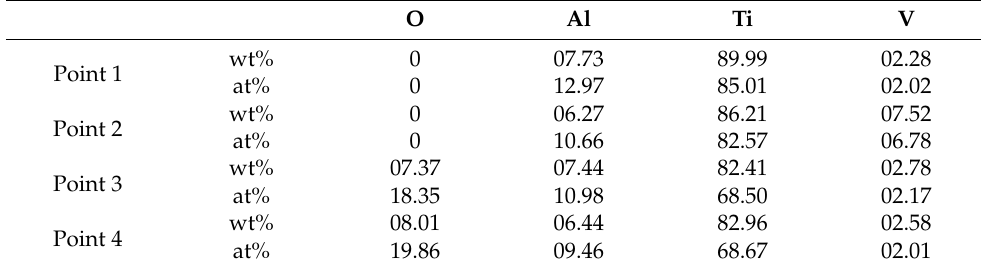
Figure 16. SEM morphologies of the TC4 alloy before ( a ) and after ( b ) potentiostatic polarization at 450 mV mse 70 ◦ C. Table 5. EDS analysis results of the TC4 alloy.